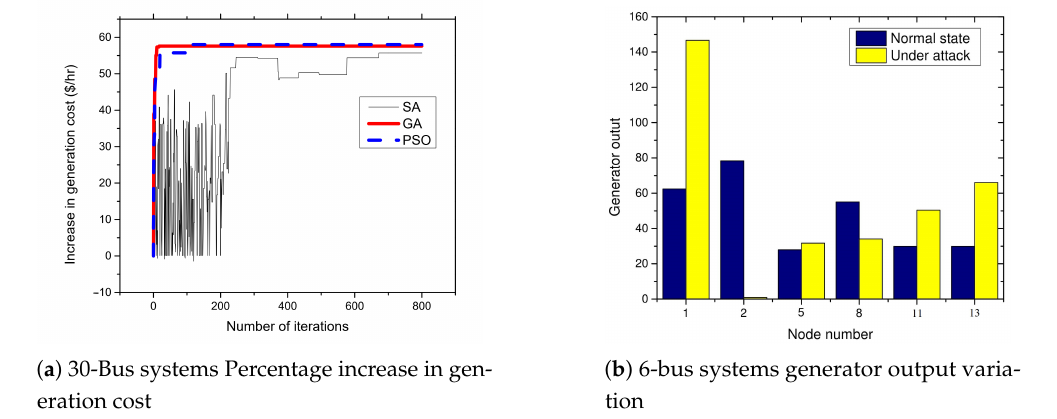
Figure 7. 30-bus systems increase in generation cost and generator output